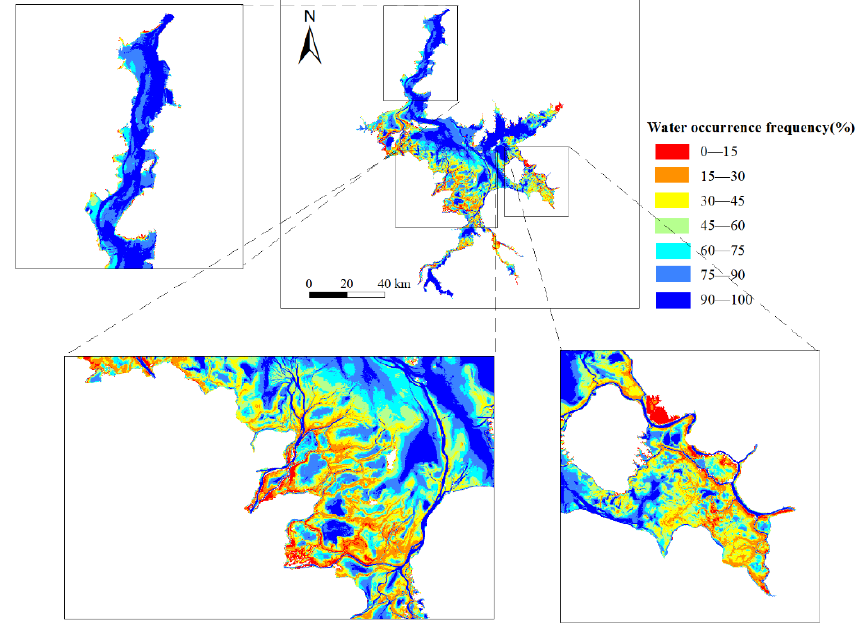
Figure 3. The water occurrence frequency of Poyang Lake. Source: EC JRC/Google.